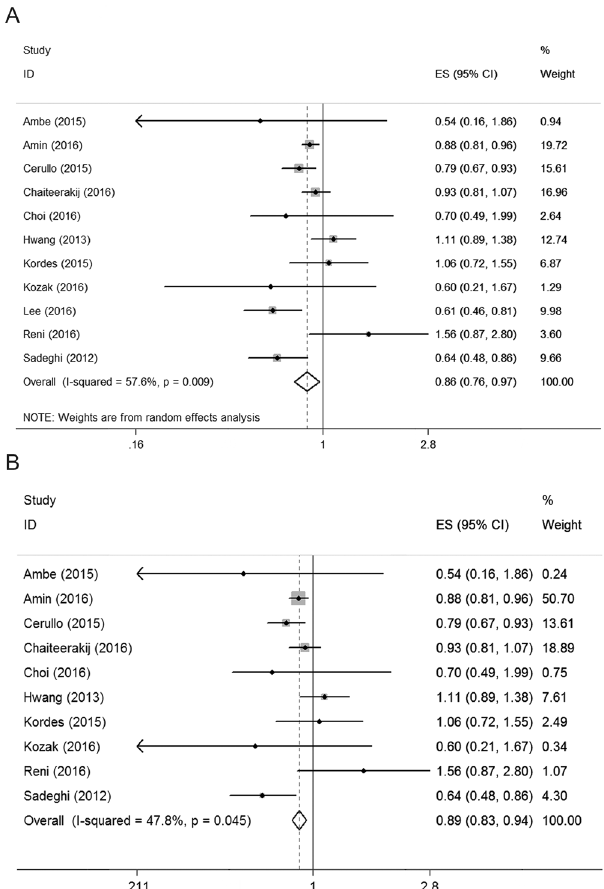
Figure 2. Forest plot for overall survival in all included studies ( A ) and sensitivity analysis excluded one study ( B